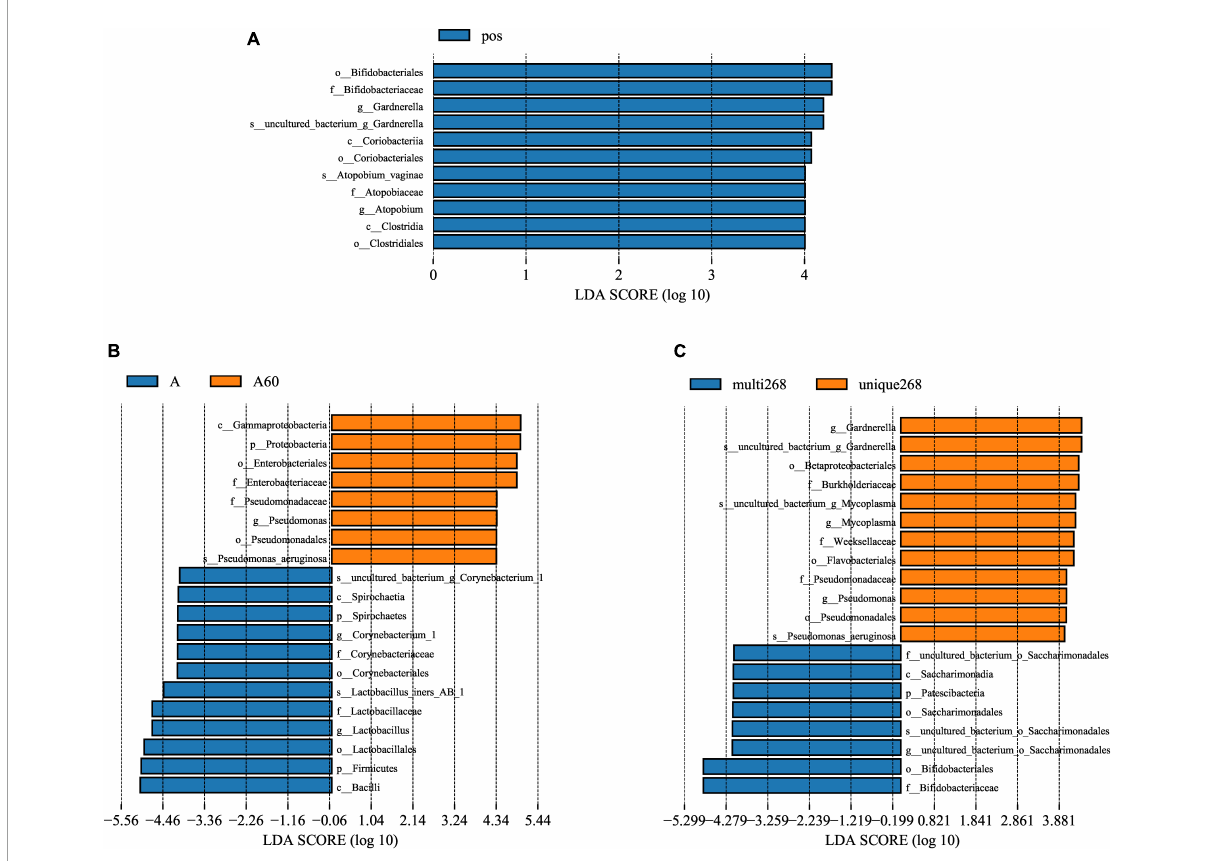
FIGURE2 Microbiota significant difference analysed by LEfSe. (A) HPV-positive and HPV-negative patient groups, (B) HPV-positive single infection and multiple infection patient groups, and (C) age above and below 60 years old patient groups. LDA score threshold set as 4, above 4 will be shown in charts. LDA, linear discriminant analysis; LEfSe, LDA effective size. HPV, Human Papillomavirus. k_: kingdom, p_: phylum, c_: class_, o_: order, f_: family_, g_: